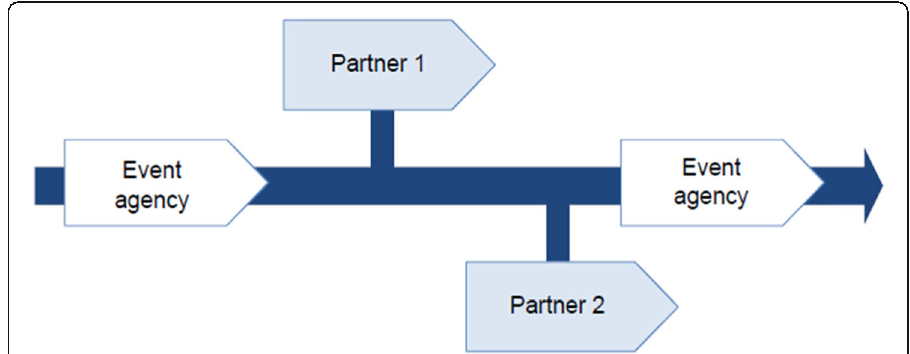
Fig. 7 The Orchestrator business model (Samsung White Paper,